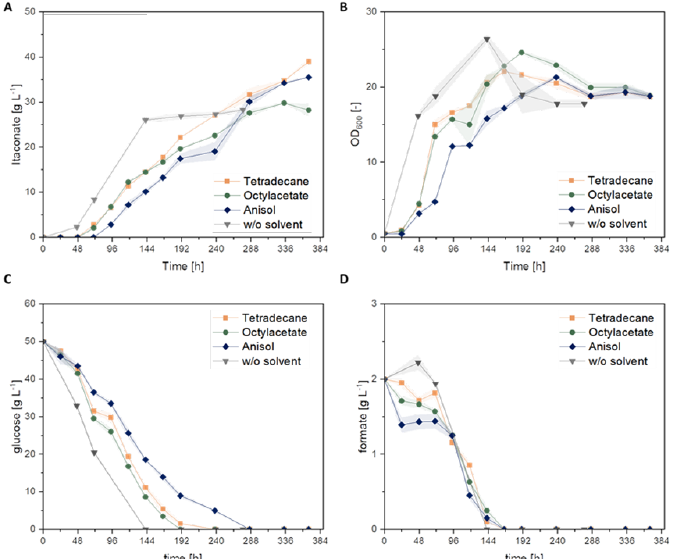
Figure 8. Tolerance of U. cynodontis ∆ fuz7 ∆ cyp3 P etef mttA ↑ P ria1 towards solvent contamination. ( A ): itaconate production, ( B ): growth via OD 600 , ( C ): glucose consumption and ( D ): formate consumption. Cultivation experiments were performed with 10% filling volume (50 mL) with addition of 1 mL organic solvent using MTM medium with 50 g L − 1 glucose, 2 g L − 1 formate, 0.8 g L − 1 NH 4 Cl. Solvents: tetradecane ( ■ yellow), octylacetate (● green), anisole ( ♦ blue) and reference (no solvent, ( ▼ grey). Cultivations were carried out in shake flasks (see Section 2.1). An amount of 33 g L − 1 CaCO 3 was used as buffer system. Error bars depict the standard deviation of the mean ( n = 3).